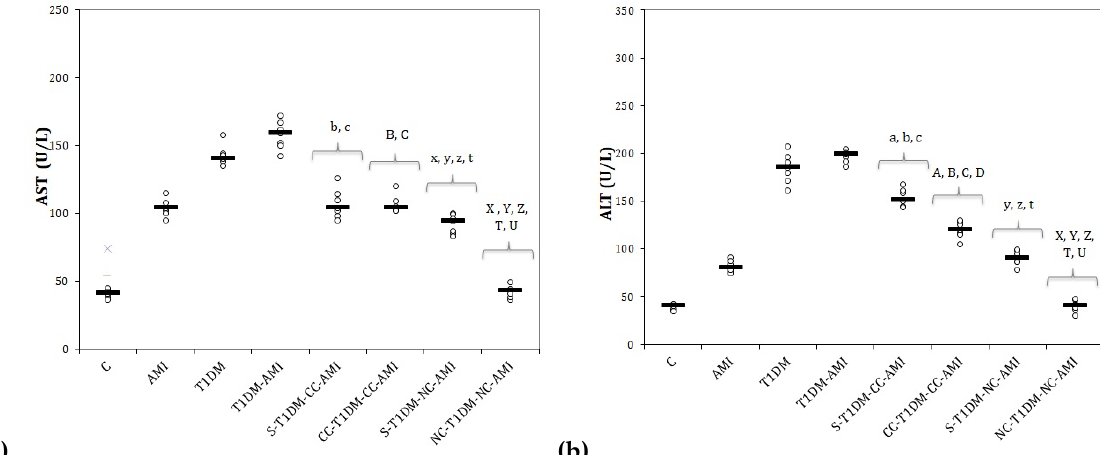
Figure 5. Serum levels of liver function parameters: ( a ) Aspartate transaminase (AST); ( b ) Alanine transaminase (ALT). C—control; AMI—acute myocardial infarction; T1DM—type 1 diabetes mellitus; S—saline (0.09%); CC—conventional